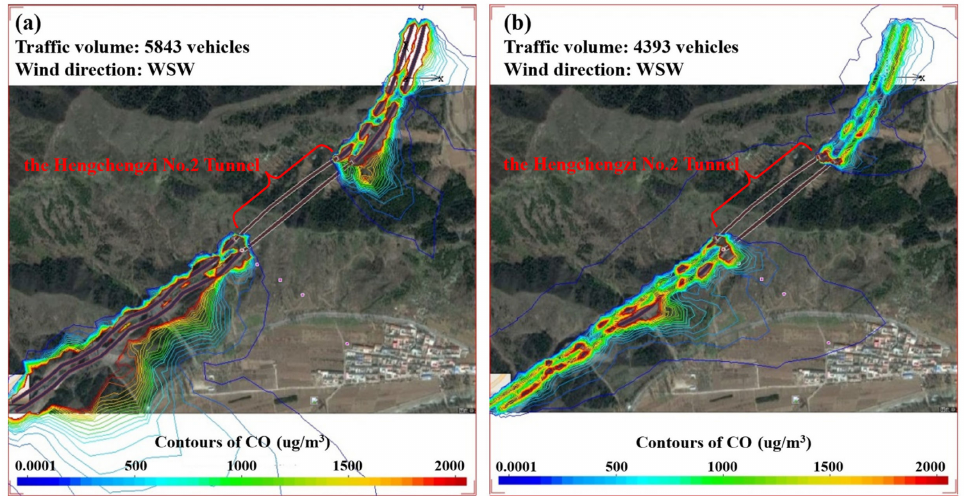
Figure 7. Hourly average concentration distribution of CO at a peak period in the Hengchengzi No. 2 Tunnel section. ( a ) 7:00–8:00; ( b )